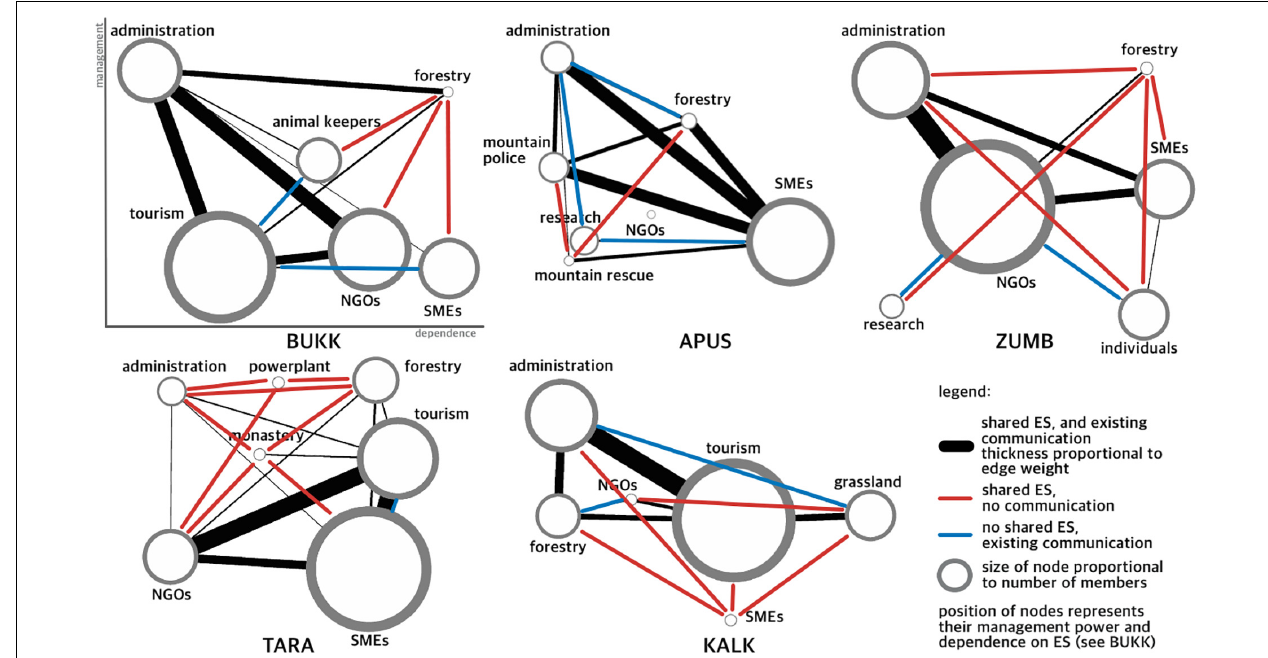
FIGURE 4 | Group-networks, power relations and unexpected communication patterns in the 5 study